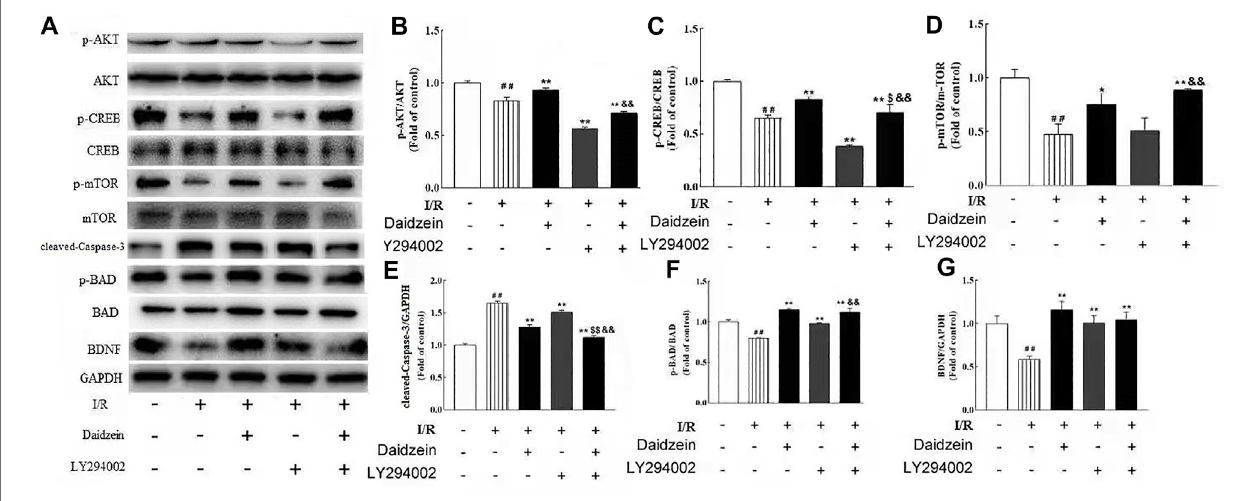
FIGURE 12 | Effect of kinase inhibitors LY294002 on neuroprotection of daidzein against I/R-induced ischemic damage in PIK3/AKT/mTOR pathway. (A) Representative western blots. (B) Ratio of p-Akt/Akt. (C) Ratio of p-CREB/CREB. (D) Ratio of p-mTOR/mTOR. (E) Ratio of cleaved-Caspase-3/GAPDH. (F) Ratio of p-BAD/ BAD. (G) Ratio of BDNF/GAPDH. Values are indicated as means ± standard errors of the means (SEMs; n (cid:2) 3). ## p < 0.01 noticeably distinct from Sham; ** p < 0.05, noticeably distinct from I/R; $ p < 0.05, $$ p < 0.01, compared to the group treated with I/R+ daidzein; && p < 0.01compared to the group treated with I/R and